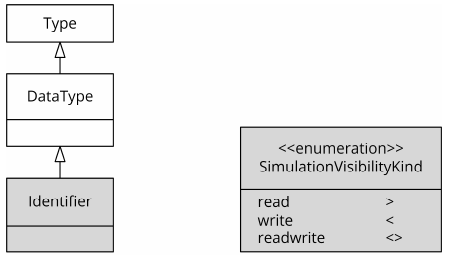
Figure 19. Simplified view on the added datatype Identifier that holds the identifier of a coded function from a parallel modeling space. The class should be specialized for specific programming languages such as Java. Additionally, the new enumeration SimulationVisibilityKind is shown, which holds the possible visibility values of SimulationProperties . White boxes represent existing UML metamodel elements and gray boxes represent newly added ones.